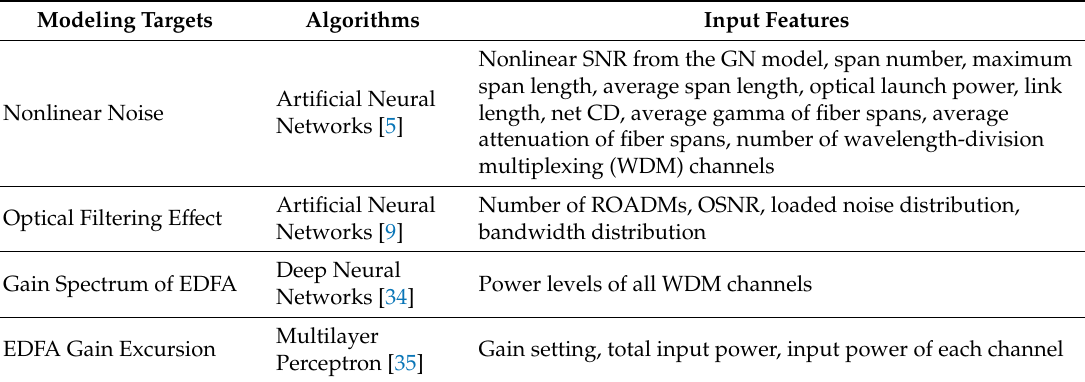
Table 2. Summary of the ML-based impairment modeling techniques discussed in Section